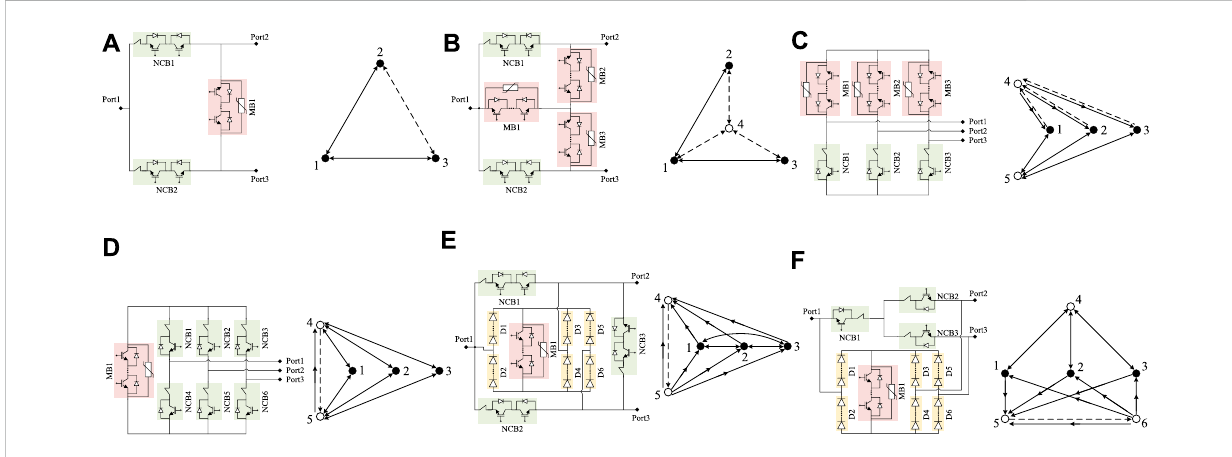
FIGURE 4 Previous three-port HCB topologies and their corresponding graphs: (A) topology proposed by Li et al. (2018), (B) topology proposed by Li et al. (2018), (C) topologyproposedbyMokhberdoranetal.(2018), (D) topologyproposedbyKontosetal.(2018), (E) topologyproposedbyHeetal.(2020),and (F) topology proposed by Xiao et al. (2020).